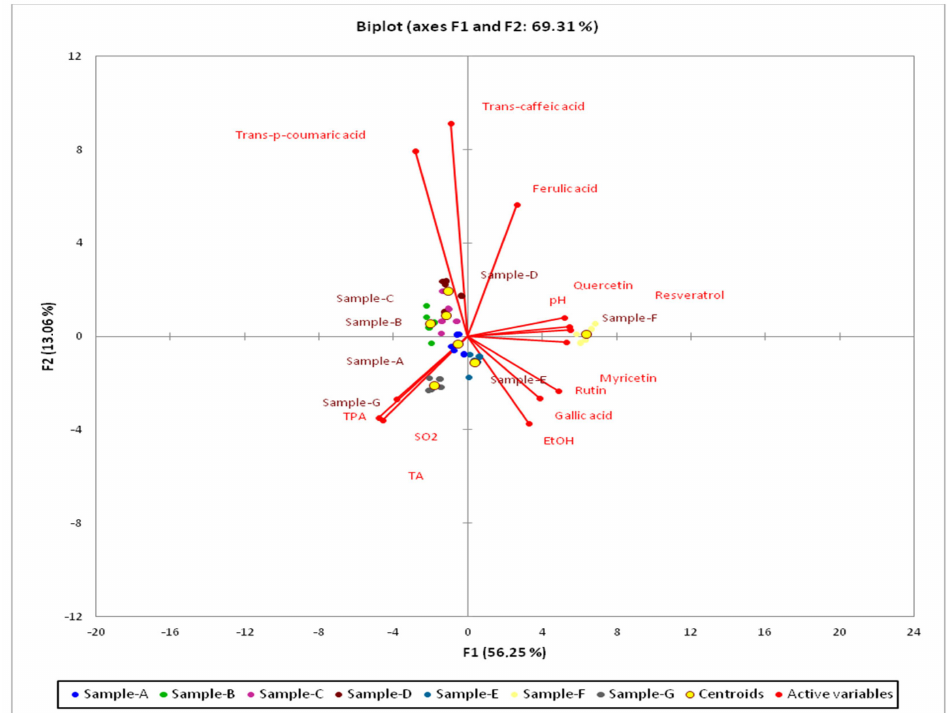
Figure 3. PCA plot of the parameters